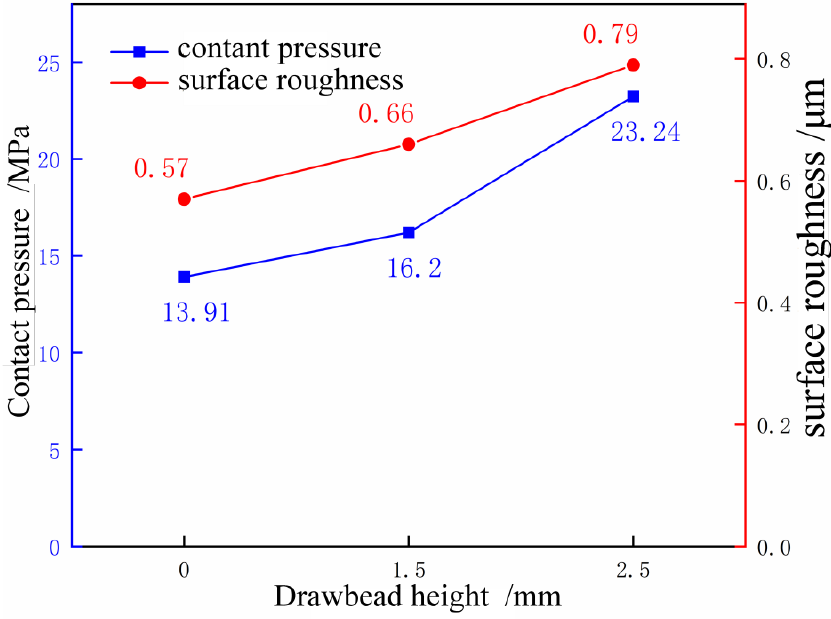
Figure 20. Contact pressure and surface roughness change curves at different drawbead height.